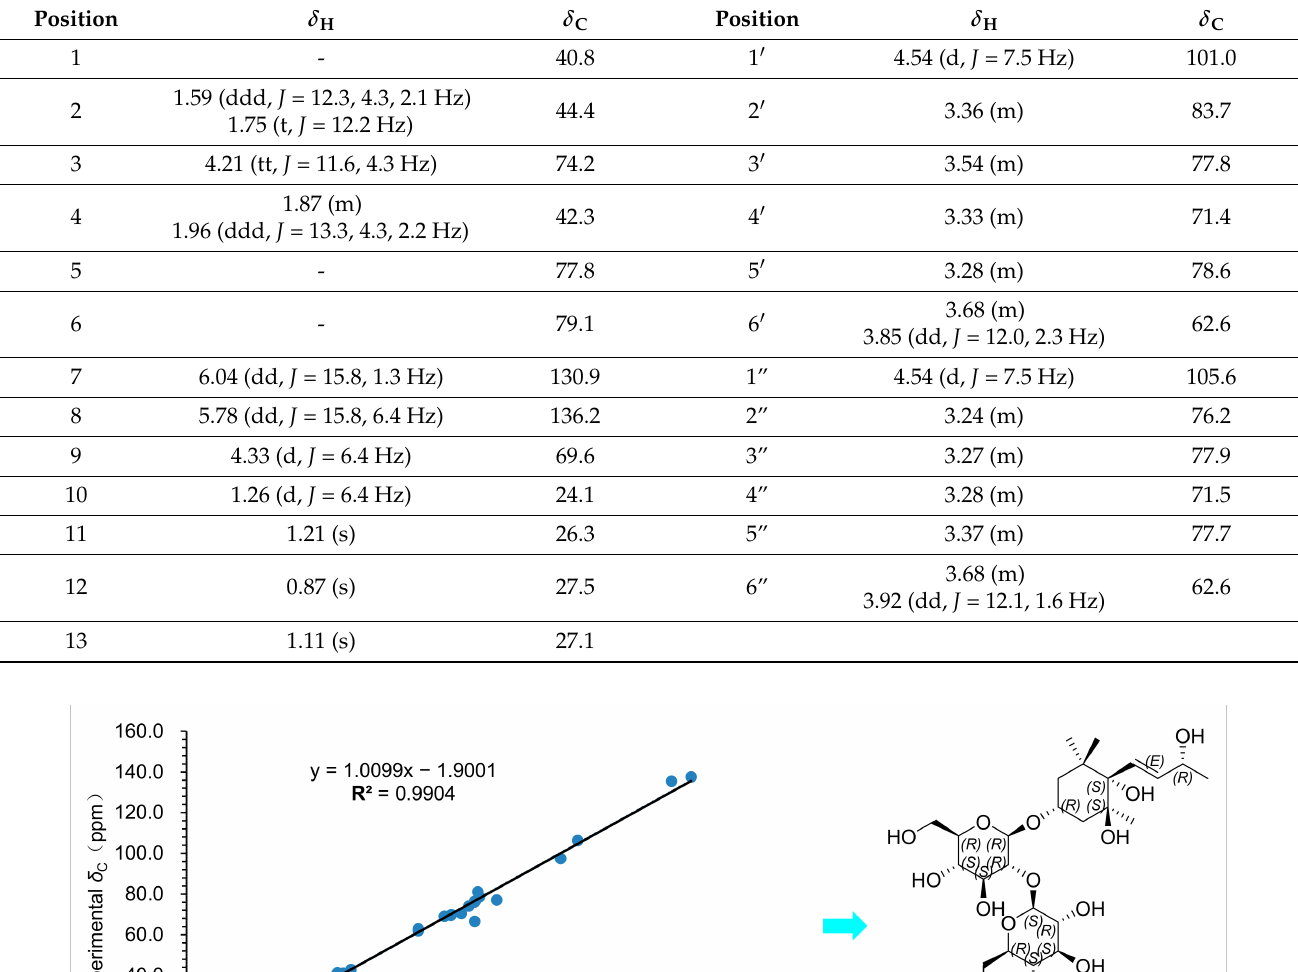
Table 1. 1 H (800 MHz) and 13 C (200 MHz) NMR data of compound 1 in CD 3 OD, ( δ in ppm, J in Hz).